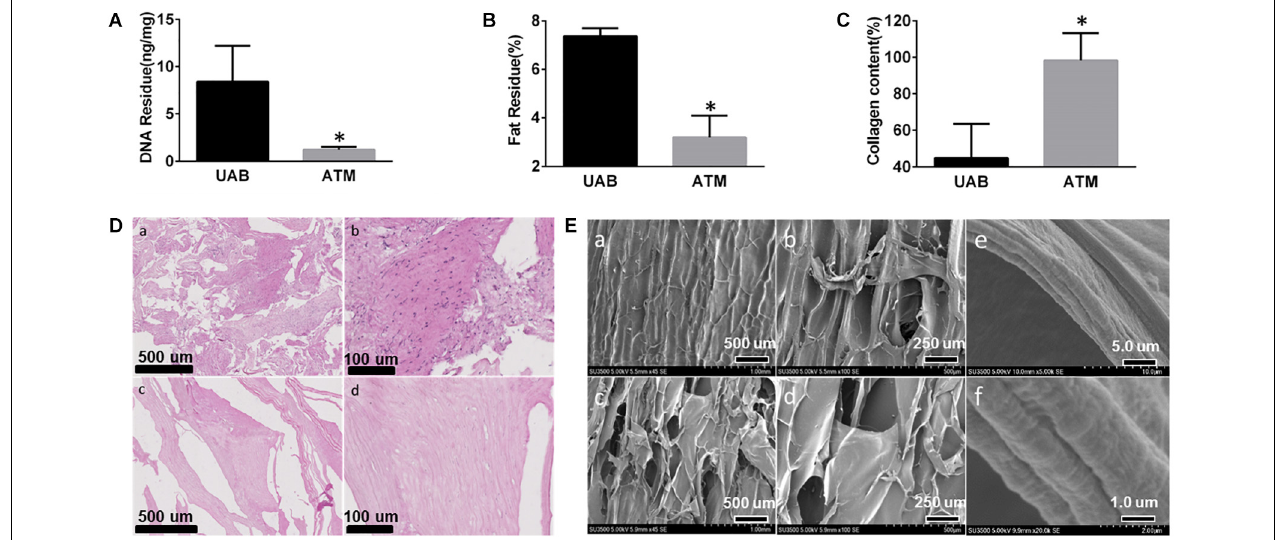
FIGURE 2 | Fish air bladder decellularization efficacy evaluation: (A) Residue DNA before (UAB, untreated air bladder) and after (ATM, acelluar tissue matrix) decellularization, DNA residue is below 2 ng/mg, which is much lower than widely accepted standard. (B) Residue fat content before (UAB, untreated air bladder) and after (ATM, acelluar tissue matrix) decellularization. (C) Collagen content after decellularization increased from 43 to 95%, indicating clearance of most generic tissue. (D) HE staining of micronized air bladder tissue before and after decellularization: (a) low mag of AB tissue before decellularization. (b) High mag of AB tissue before decellularization. (c) Low mag of AB tissue after decellularization. (d) High mag of AB tissue after decellularization. (E) SEM micrograph of AB tissue: (a) low mag of AB tissue before decellularization; (b) High mag of AB tissue before decellularization; (c) Low mag of AB tissue after decellularization; (d) High mag of AB tissue after decellularization; (e) Low mag; and (f) High mag of collagen fibril morphology exhibiting microstructure was preserved with the collagen fibers. ∗ Represent significant difference between UAB and ATM ( p < 0.05).